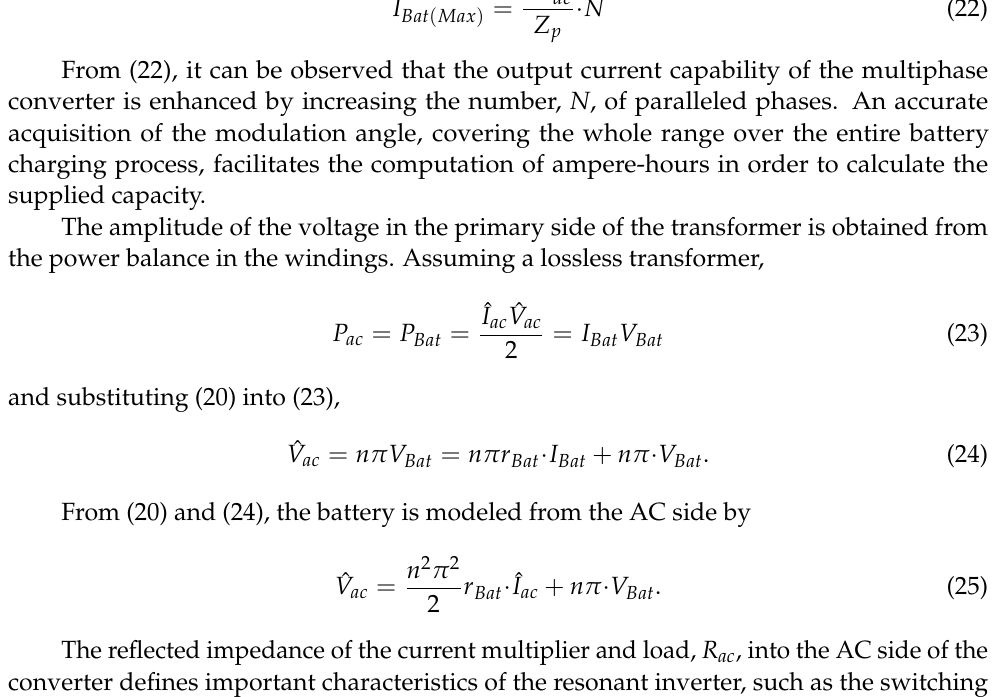
Figure 9. Amplitude of the normalized charging current, I Bat , as a function of the control angle, Ψ , for N = 2, 3, and 4. All phases are evenly shifted, Ψ 0 = 0 ◦ , Ψ 1 = Ψ , Ψ 2 = 2 Ψ , . . . , Ψ N − 1 = ( N –1) Ψ . Working with (21), the maximum charging current is achieved at Ψ 0 = Ψ 1 = Ψ N − 1 = 0 ◦ and is given